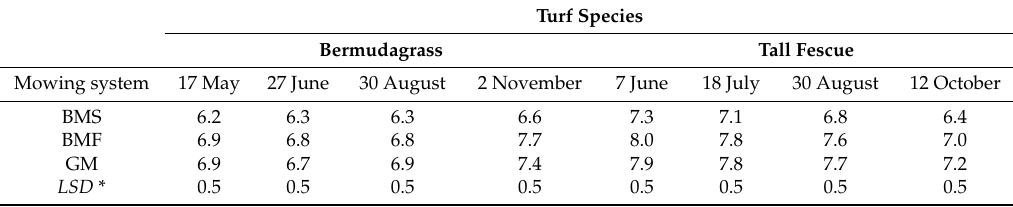
Table 2. Mowing system mean effect on bermudagrass and tall fescue turf quality (1 = poor, 9 = excellent), where BMS = battery-powered mower revving at 3000 rpm, BMF = battery-powered mower revving at 5000 rpm and GM = gasoline-powered